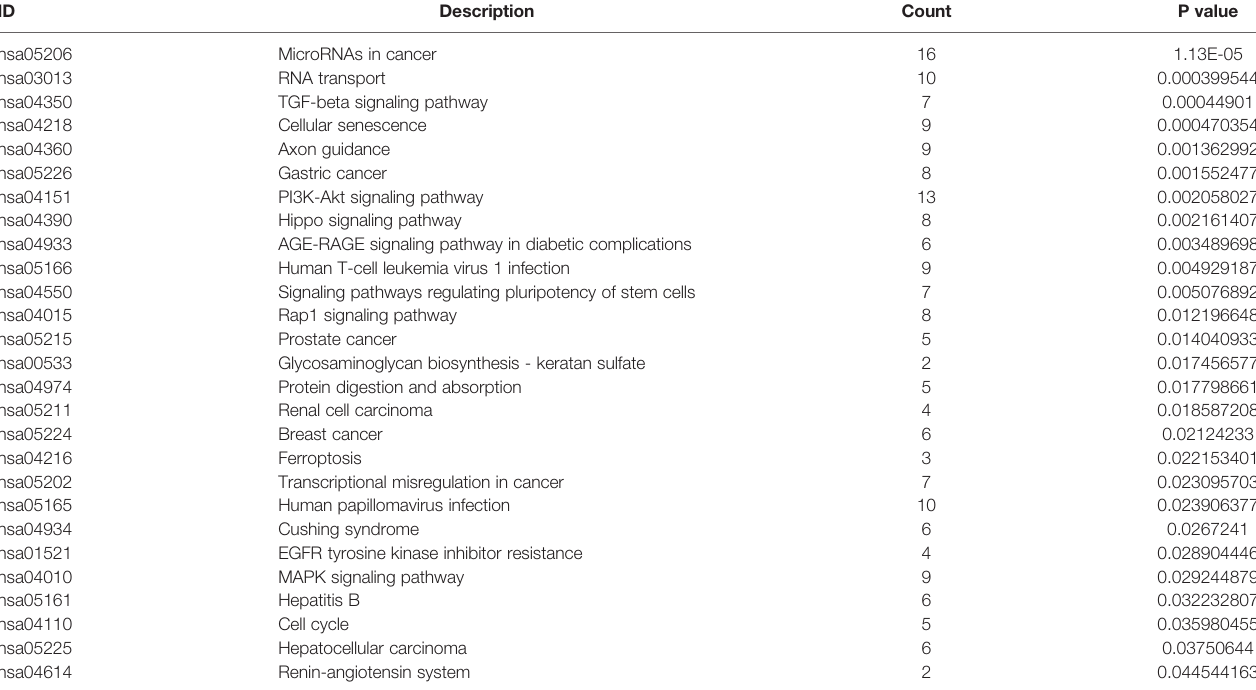
TABLE 2 | KEGG showed that the signaling pathways involved in the ceRNA network mechanism.